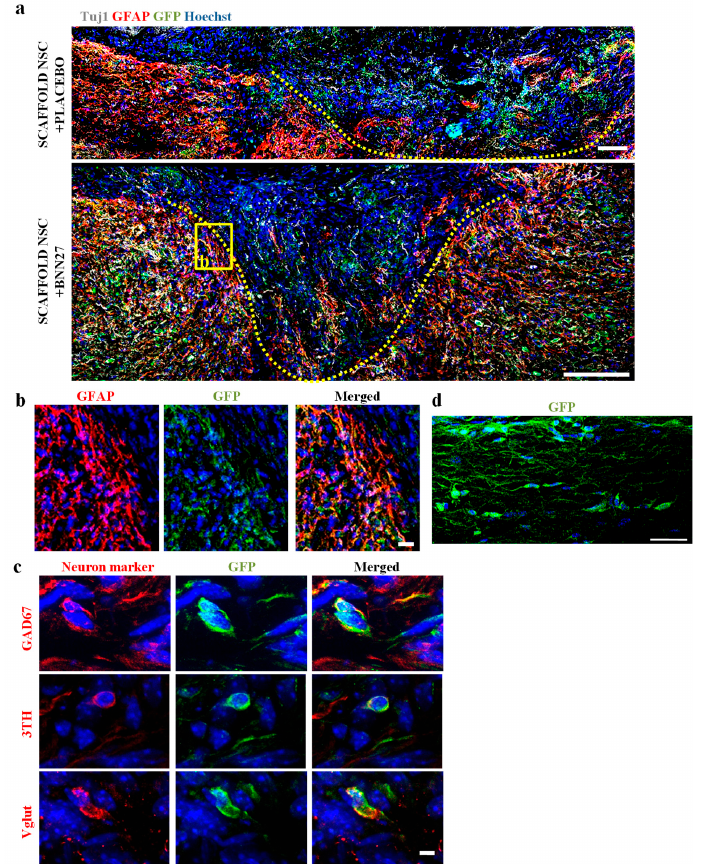
Figure 4. Spatial patterning of implanted NSC fate at the spinal cord lesion site. ( a ) Representative fluorescence images of spinal cord parasagittal sections of SCI lesion immunostained for Tuj1 + neurons (gray), GFAP + astrocytes (red) and GFP + implanted NSC-derived cells (green). The boundaries of lesion sites are marked with a dotted line. Scale bars: 100 μ m. ( b ) High-magnification fluorescence image of the rectangular insert of image ( a ) showing GFP + GFAP + implanted NSC-derived astrocytes at the lesion boundary region. Scale bar: 30 μ m. ( c ) Representative high-magnification fluorescence images of GFP + implanted NSC-derived cells double-immunostained with markers of different neuron types: GAD67 (inhibitory GABAergic neurons; upper row), 3TH (dopaminergic neurons; middle row) and VGLUT1 (excitatory glutamatergic neurons; lower row) (red). Scale bar: 3 μ m. ( d ) Representative fluorescence image of a spinal cord parasagittal section showing GFP + implanted NSC-derived cells located in the dorsal column, approximately 250 μ m caudally to the lesion. Scale bar: 30 μ m.